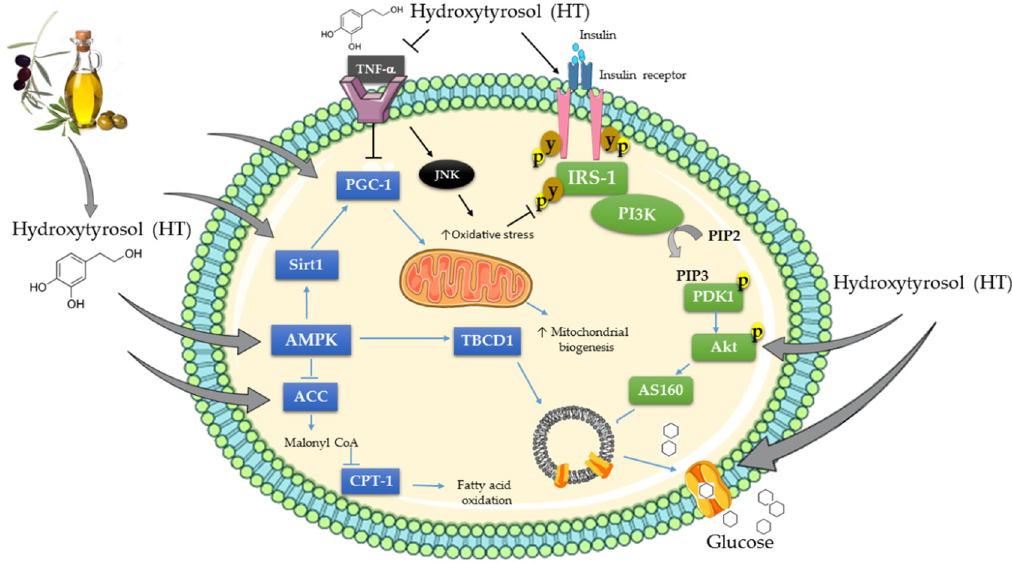
Figure 2. E ff ects of HT on cellular signaling molecules. The figure was created based on the evidence of the studies [33,37,43,64,70,78].